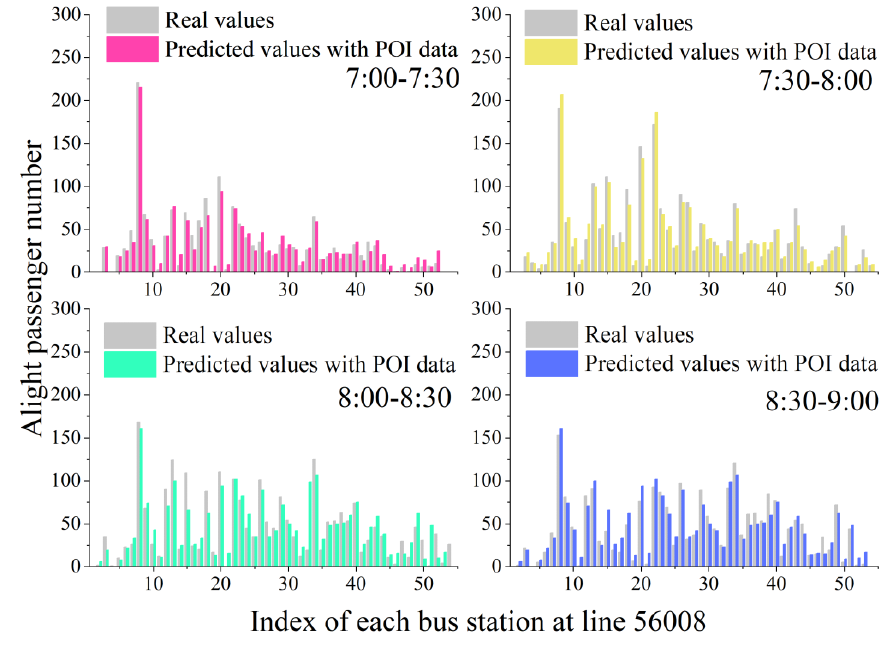
Figure 4. Prediction and true values of alighting passenger number for line